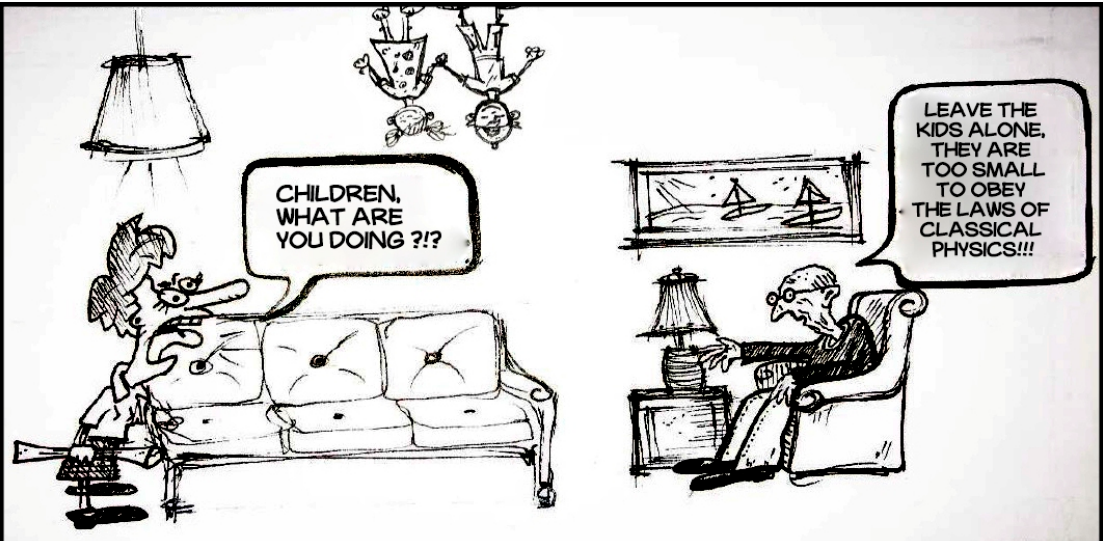
Figure 6. Cartoon sketch of the limitations of classical physics and “strangeness” of quantum me- chanics.